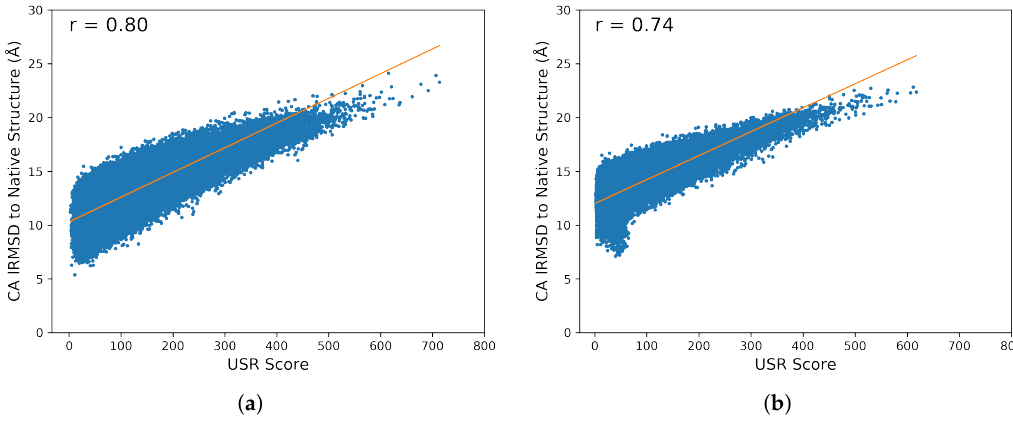
Figure 8. Correlation between USR scores and lRMSDs to the native structure of all tertiary structures computed on a target protein in the ( a ) benchmark dataset (with native structure under PDB id 1cc5) and ( b ) CASP dataset (with native structure under CASP id